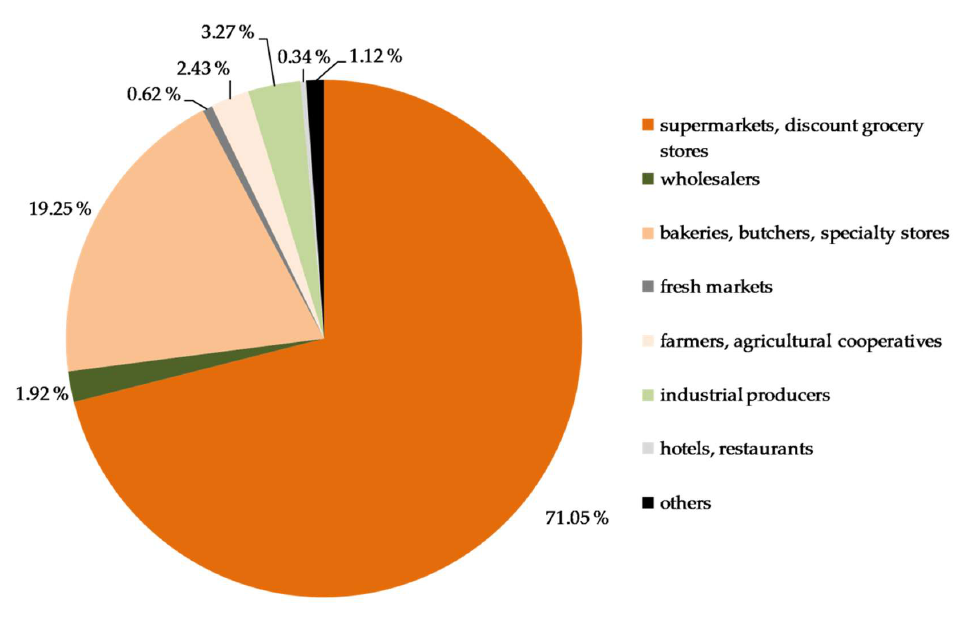
Figure 4. Types of regular food donors of participating food banks in percent, 2017.